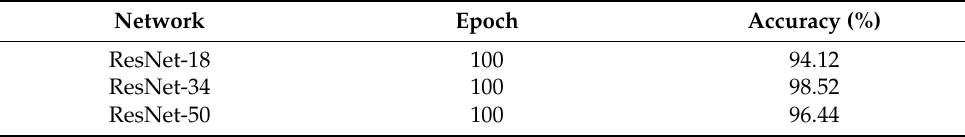
Table 6. Average classification accuracy of different residual